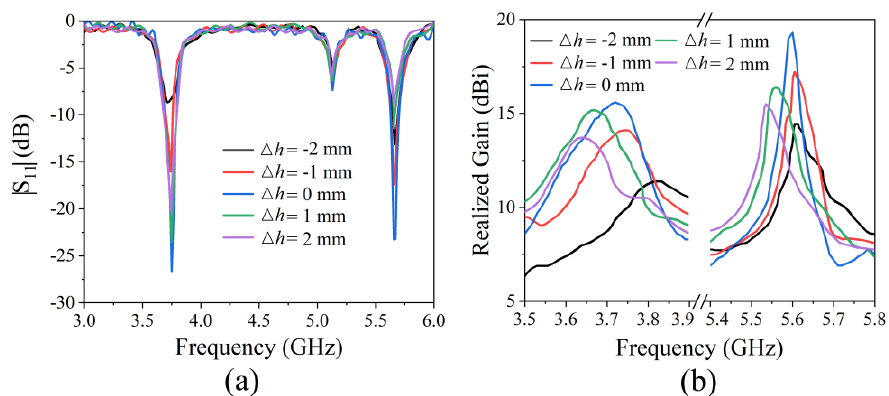
Figure 14. Measured (solid lines) and simulated (dashed lines) radiation patterns on the ( a , c ) E- plane and ( b , d ) H-plane. Measured results ( a , b ) at 3.75 GHz and ( c , d ) 5.60 GHz. Simulated results ( a , b ) at 3.73GHz and ( c , d ) 5.66 GHz. The black lines are the results for the metamaterial antenna, and the red lines are the results for the feed patch antenna.